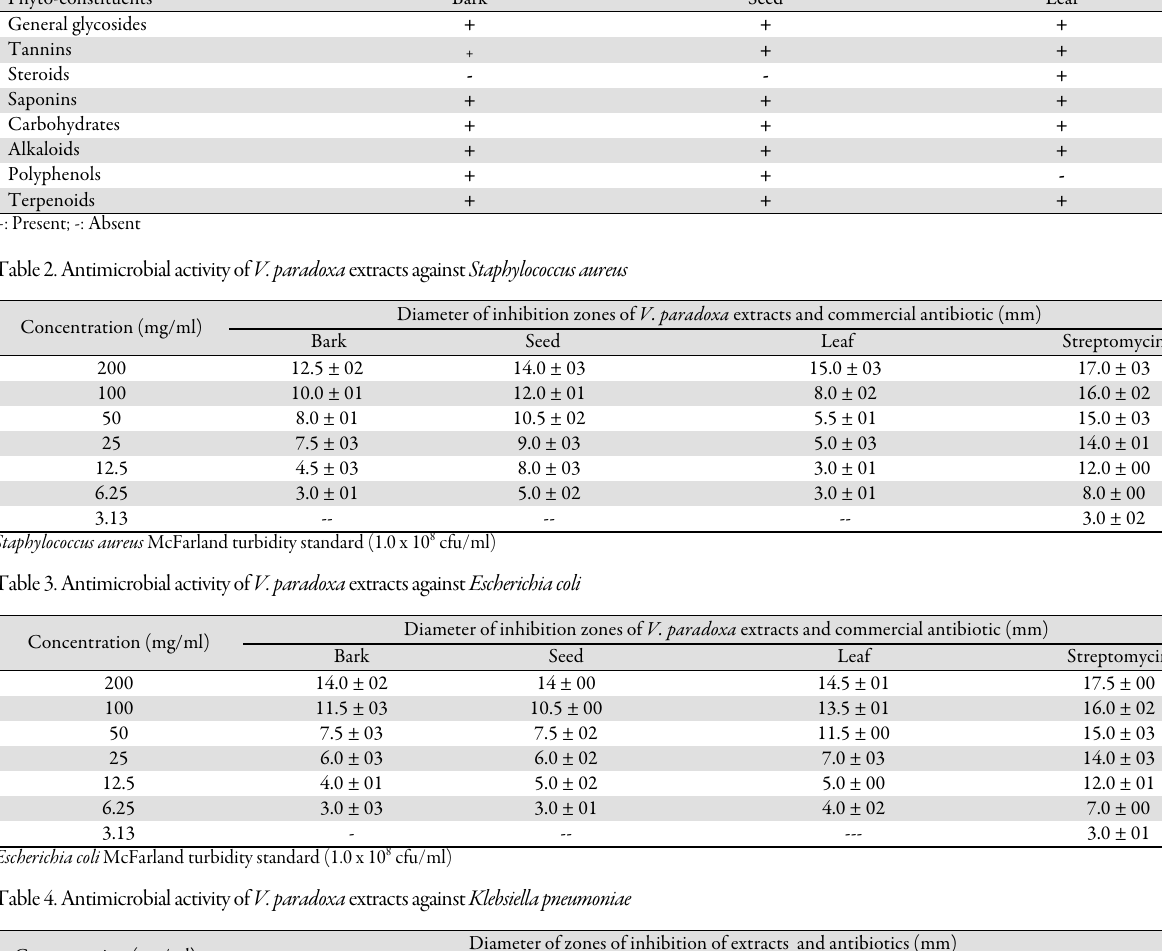
Table 1. Phytochemical screening of crude extracts of Vitellaria paradoxa Phyto-constituents Bark General glycosides